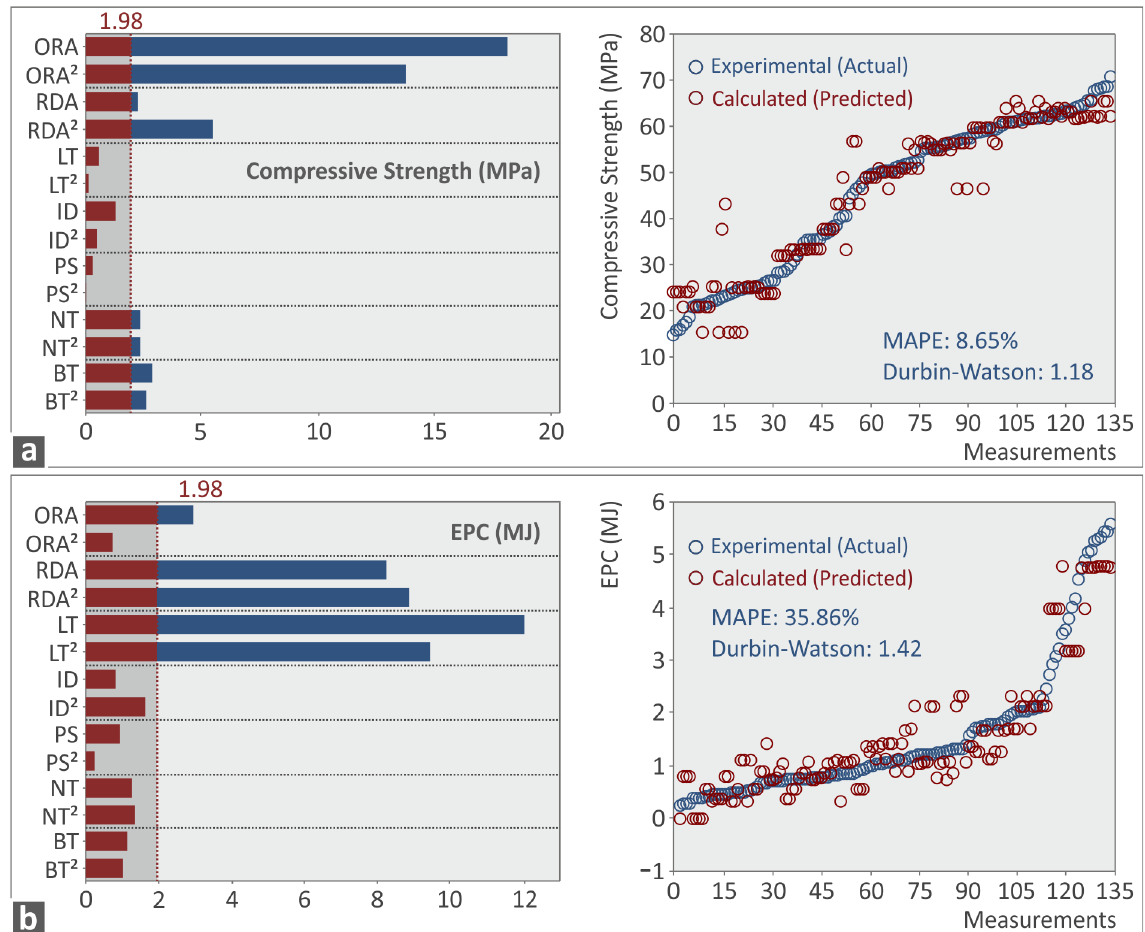
Figure 12. Pareto chart for ( a ) compressive strength (MPa) and the ( b ) energy (MJ). The statistically significant parameters are those crossing the threshold value of 1.98. On the right side, the experimental vs. the predicted values are presented.